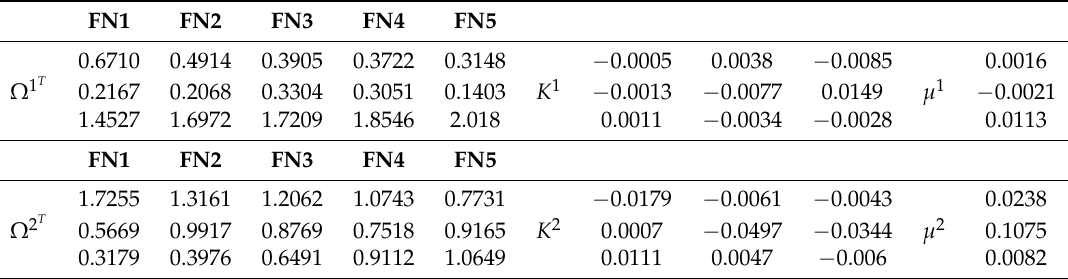
Table 4. ICE U.K. futures: parameters of the underlying risk